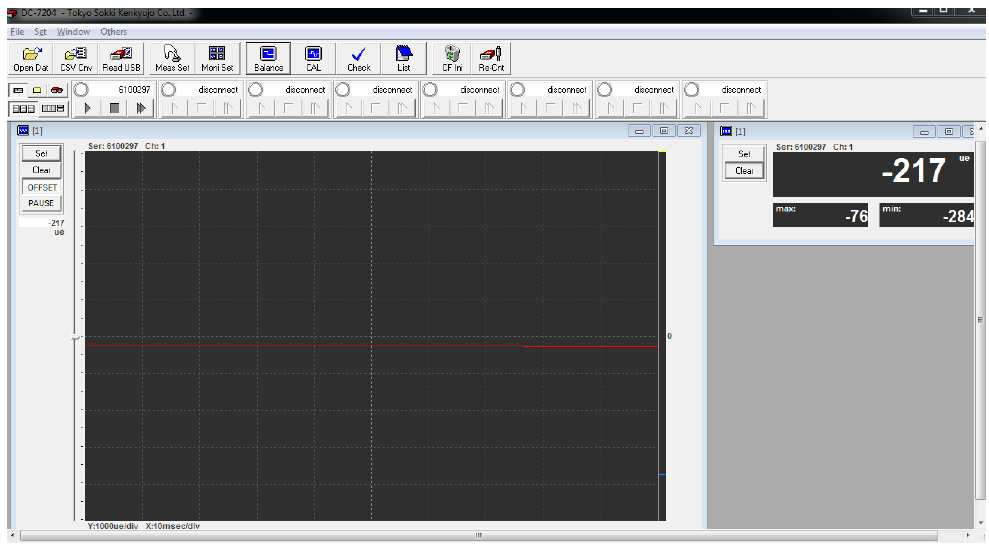
Figure 5. Measurement and control software window.